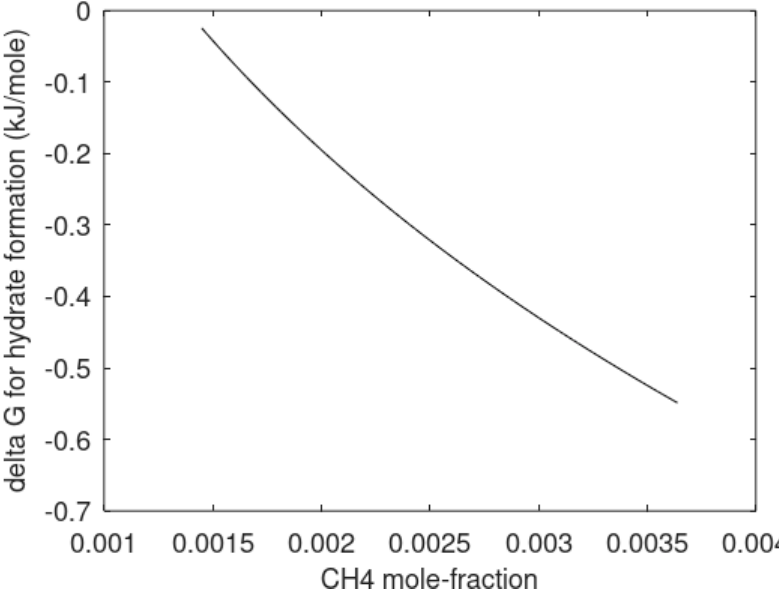
Figure 22. Free energy change for CH 4 hydrate formation from dissolved CH 4 in water, and liquid water, as function of CH 4 mole-fraction in water. Temperature 280 K and pressure 180 bar.